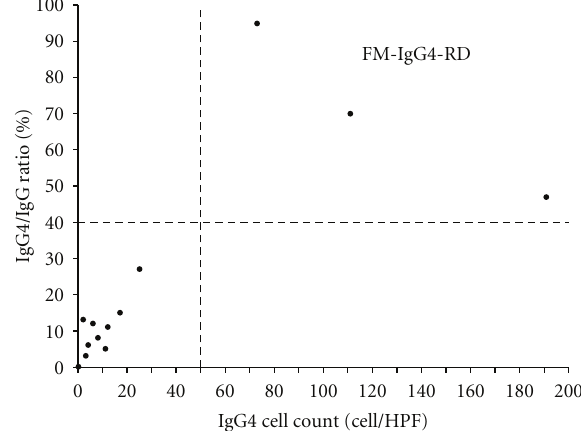
Figure 2: Number of IgG4-positive plasma cells and the corre- sponding IgG4 + /IgG + ratios in FM patients ( n = 15, 3 patients had no IgG4 positive plasma cells).